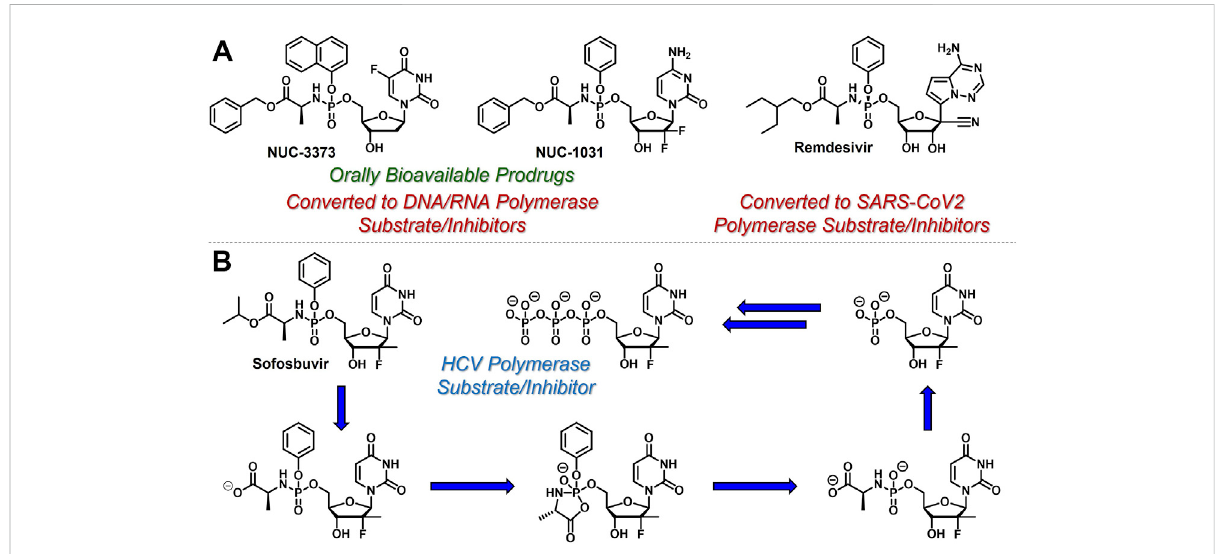
FIGURE 4 Selected structures of phosphoramidate or ProTide prodrugs of (A) anticancer (e.g., NUC- 3,373 and NUC-1031) and antiviral (e.g., remdesivir) nucleotide-based therapeutics. (B) The metabolic activation pathway of ProTides as highlighted by sofosbuvir.